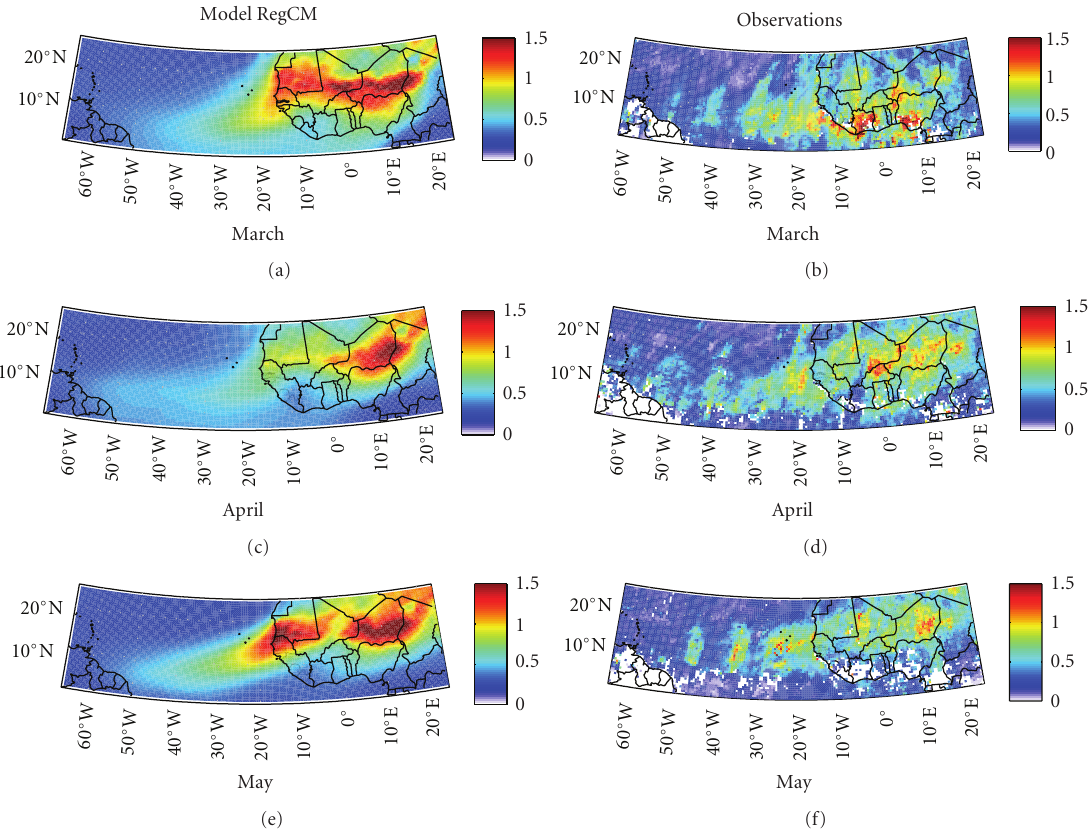
Figure 1: Comparison of monthly mean values of AOD during the year 2010: (a) RegCM for March, (b) MISR observations for March, (c) RegCM for April, (d) MISR observations for April, (e) RegCM for May, and (f) MISR observation for